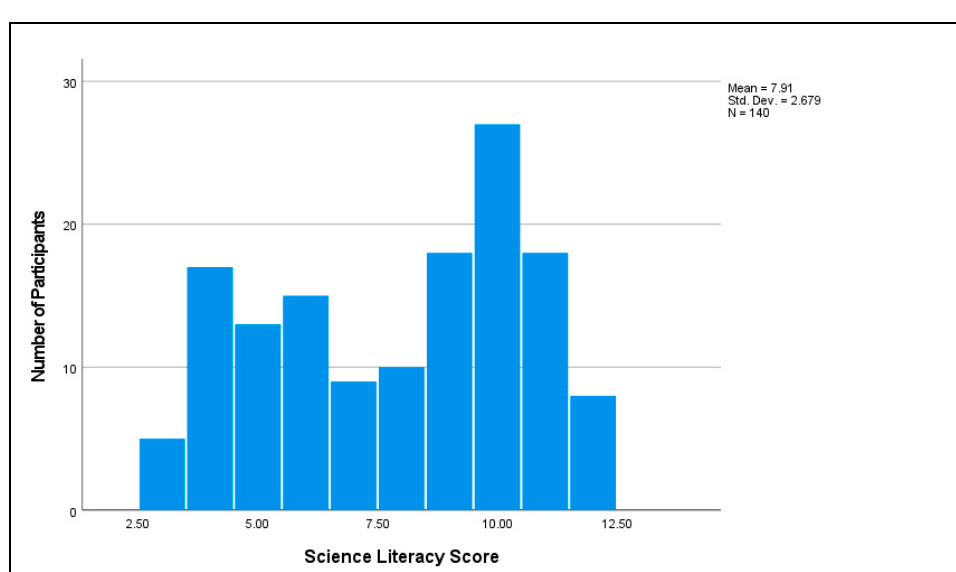
Figure 4. Participants’ information literacy.